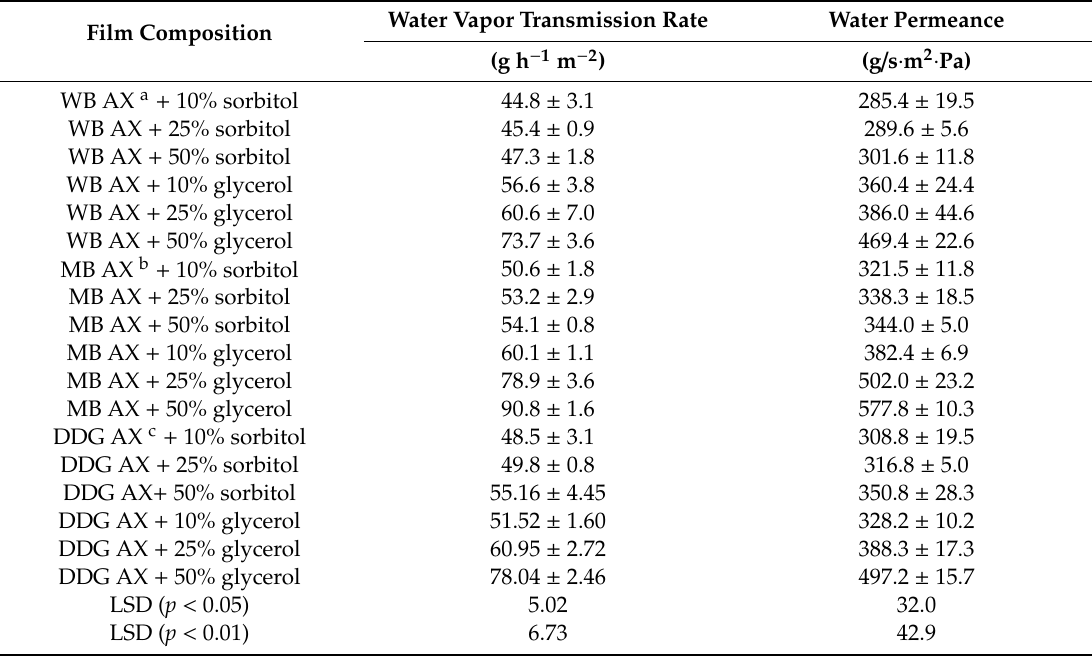
Table 3. Water vapor transmission rate and water permeance of wheat bran arabinoxylan, maize bran arabinoxylan, and dried distillers grain arabinoxylan